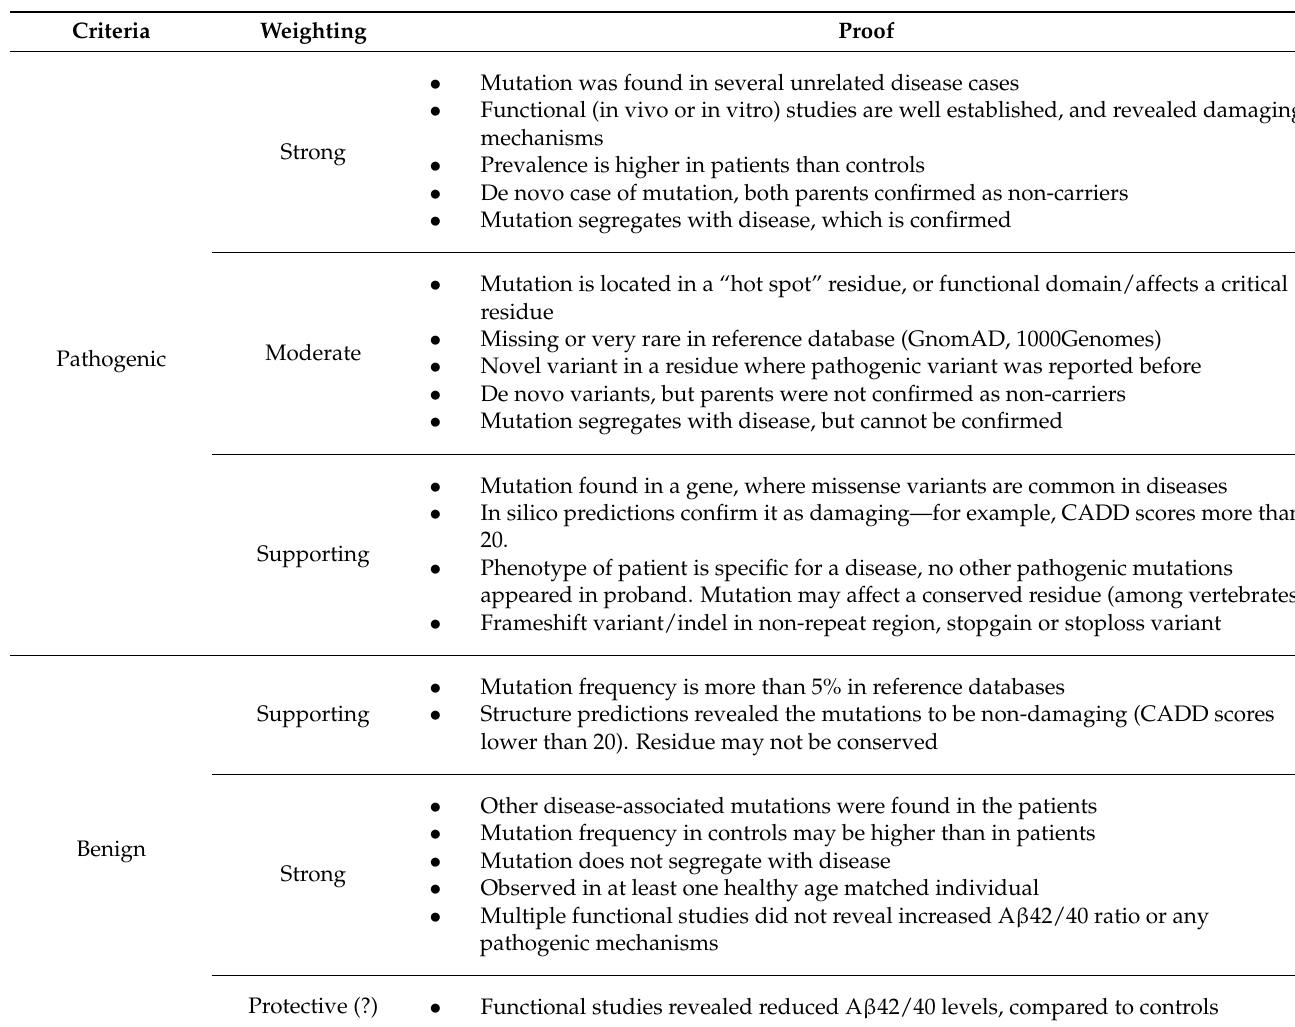
Table 1. Categorizing EOAD-related (including PSEN1) mutations based on the ACMG-AMP guide- lines